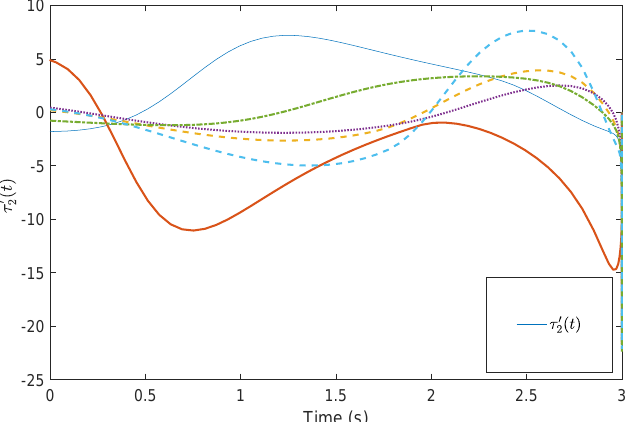
Figure 13. Control input τ (cid:48)